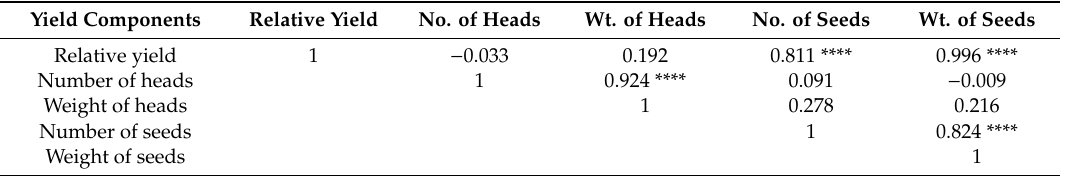
Table 11. Pearson’s correlation coe ffi cients ( r ) between yield / yield components of sunflower. Yield Components